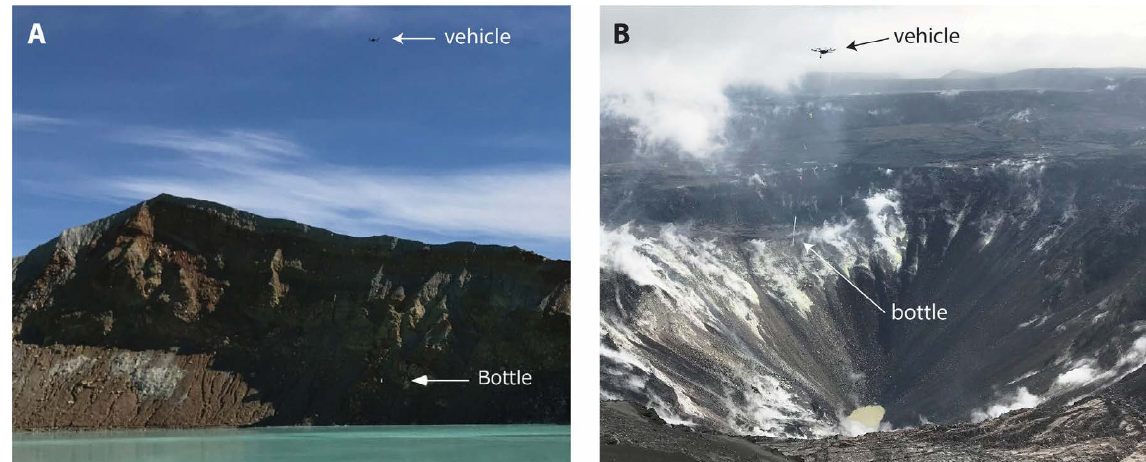
Figure 18: Water sampling, [A] at Yugama crater lake (reproduced from [Terada et al. 2018] under the Creative